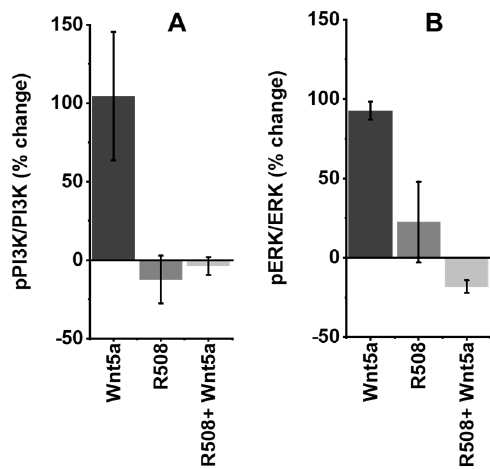
Figure 4. Effect of R508 on WNT5A signaling. ELISA (active motif) assays were used to quantify ( A ) P-PIK3CA and PIK3CA as well as ( B ) P-ERK and ERK 12 hours after treatment, as per the Materials and